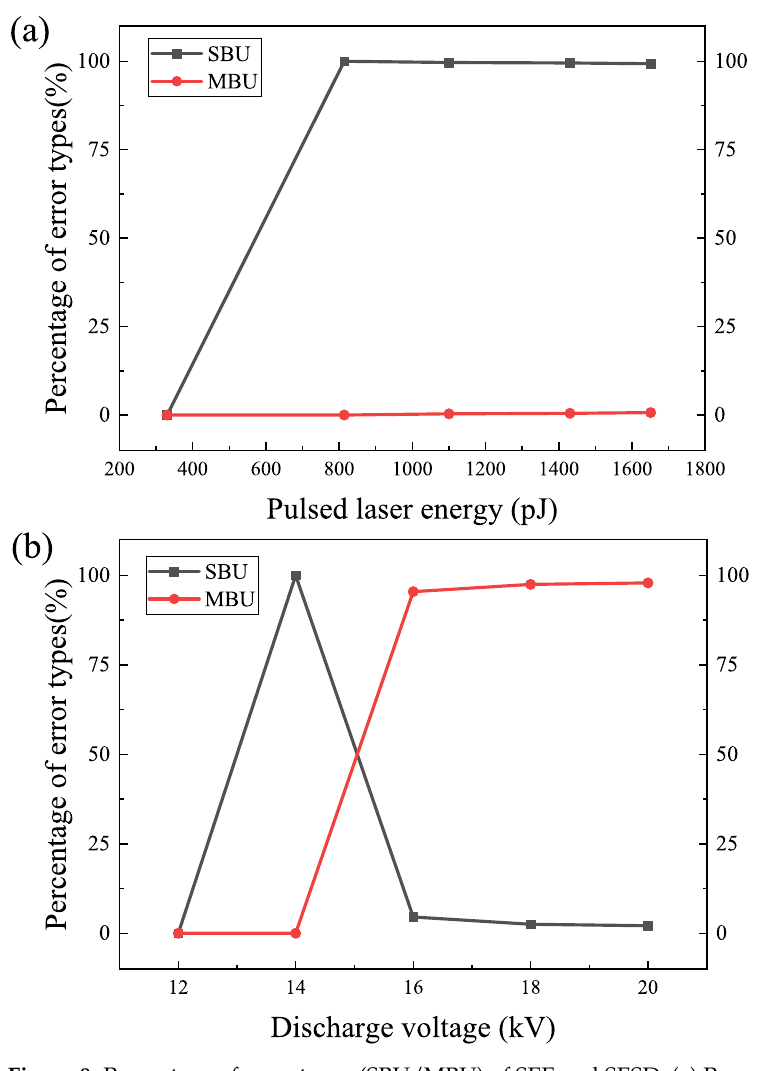
Figure 8. Percentage of error types (SBU/MBU) of SEE and SESD. ( a ) Percentage of SBU and MBU with the variation of pulsed laser energy. ( b ) Percentage of SBU and MBU with the variation of discharge